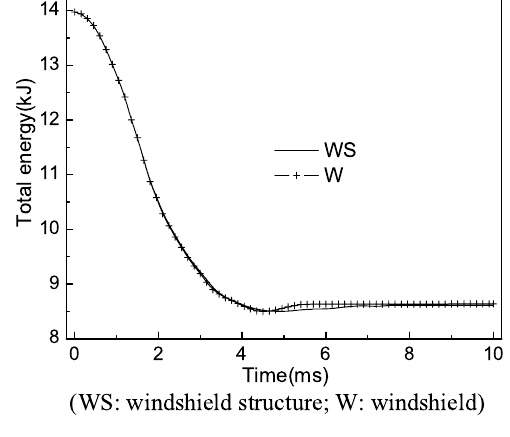
Fig. 24. Time history of total energy of bird.